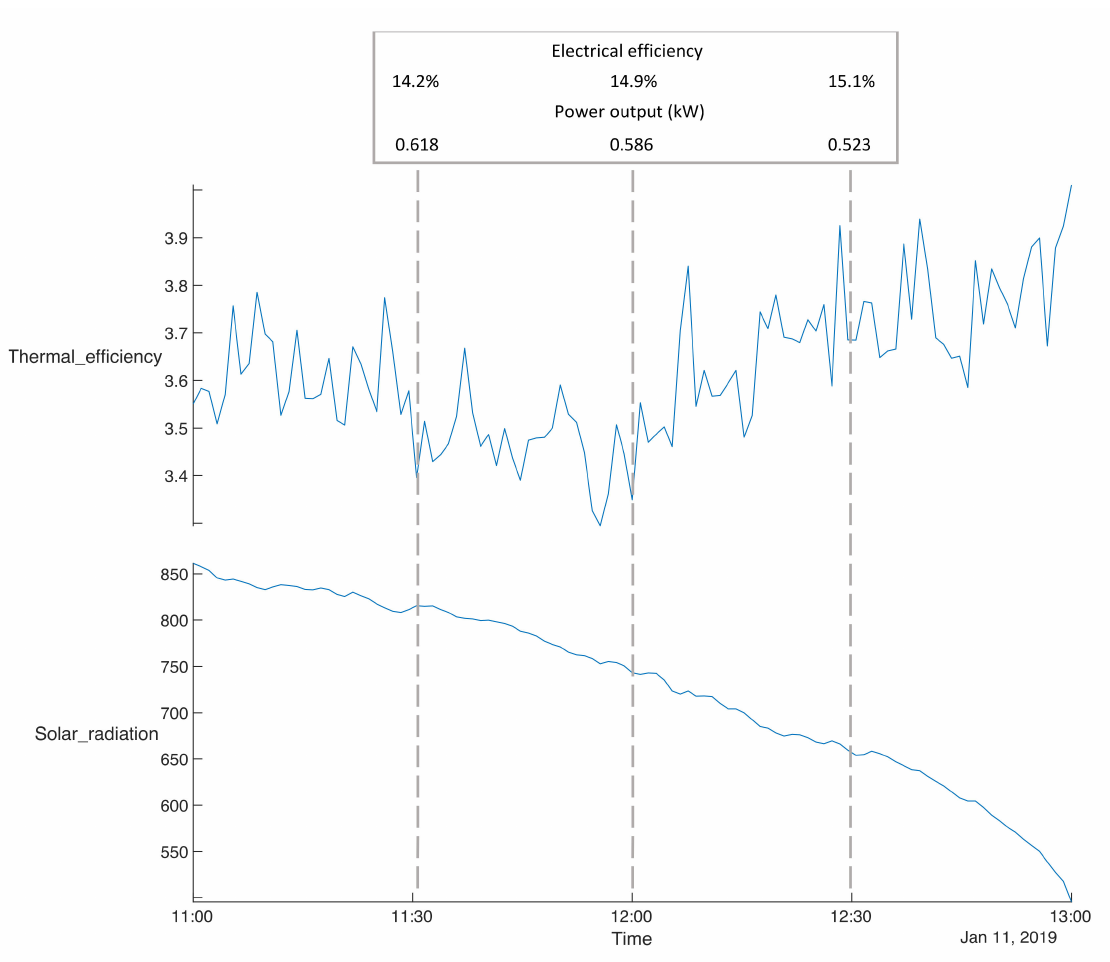
Figure 12. BIPVT system thermal efficiency (%) profile for heating purposes, electrical efficiency and direct solar radiation on the vertical surface (W/m 2